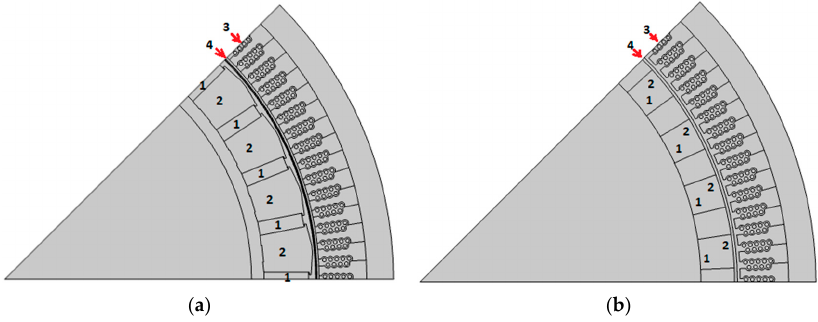
Figure 4. Generator topologies: ( a ) Spoke-type ( b ) Surface-mounted. 1. Permanent magnet, 2. Rotor pole 3. Stator slots with coils 4. Air gap.